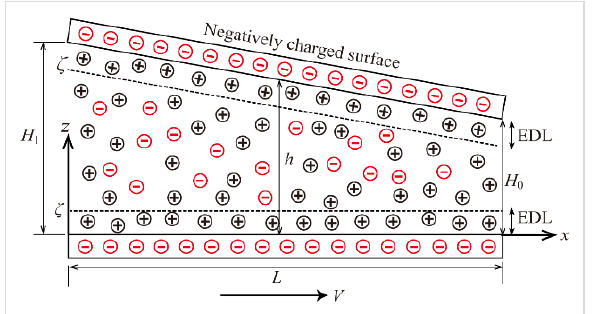
Figure 1: The schematic of hydrodynamic lubrication in a 1D slider bearing considering the effect of the EDL. h is a variable to indicate the lubricant film thickness, H 0 and H 1 are the lubricant film thickness at the outlet and inlet of bearing, respectively, L is the length of the bear- ing, V is the sliding velocity of the lower bearing surface, and x and z are the coordinate